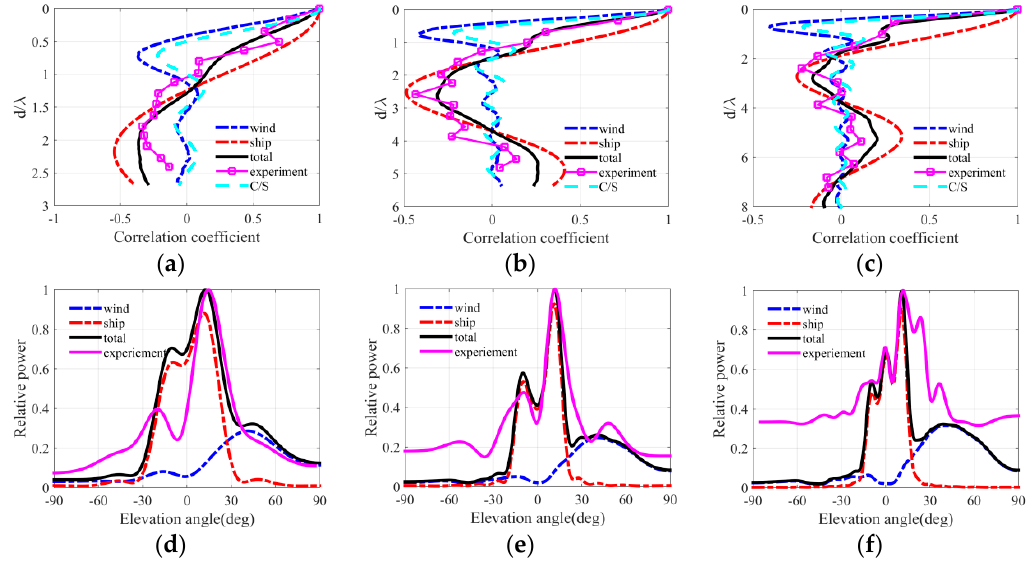
Figure 14. Vertical correlation coefficient and directionality at 3:00, 13 August for frequencies of ( a , d ) 50 Hz, ( b , e ) 100 Hz and ( c , f ) 150 Hz.